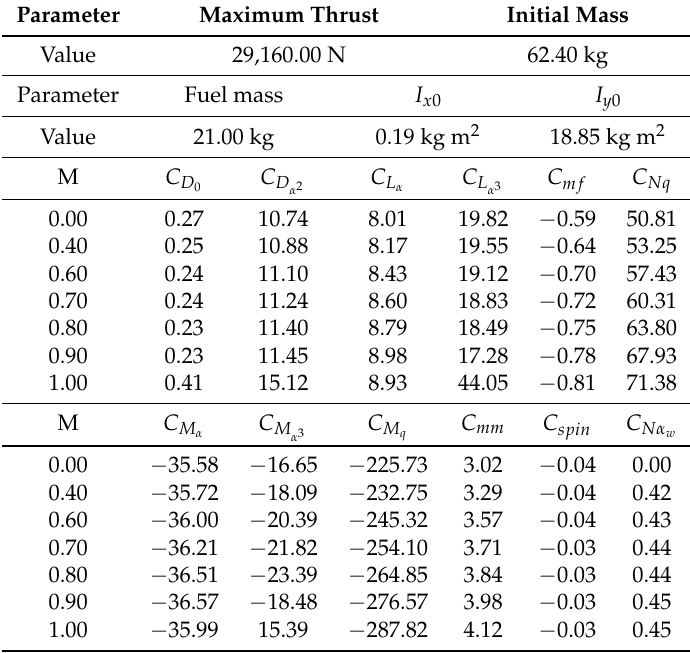
Table 1. Aerial vehicle